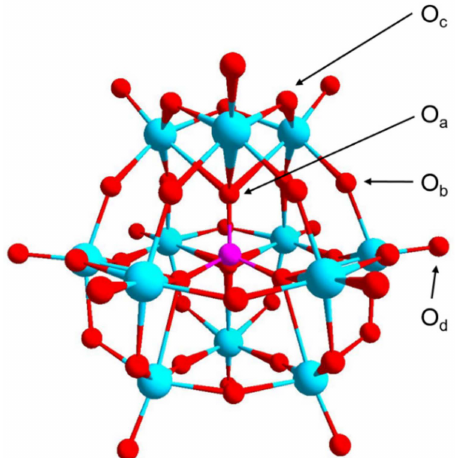
Figure 1. The structure of Keggin-type polyoxometalates (POMs), taking PW 12 O 403 − as an example, identifying the four types of oxygen in the structure: the central oxygen atom (O a ); the bridging oxygen atom that bridges two tungsten atoms not sharing a central oxygen atom (corner-sharing, O b ); the bridging oxygen atom that bridges two tungsten atoms sharing a central oxygen atom (edge-sharing, O c ) and the terminal oxygen atom (O d ). P, pink ball; W, blue ball; O, red ball. Reproduced with permission from [20]. Copyright (2003)